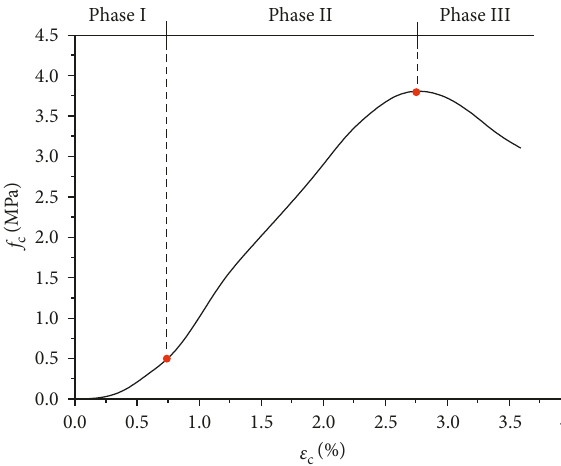
Figure 11: Stress-strain diagram of CEB to